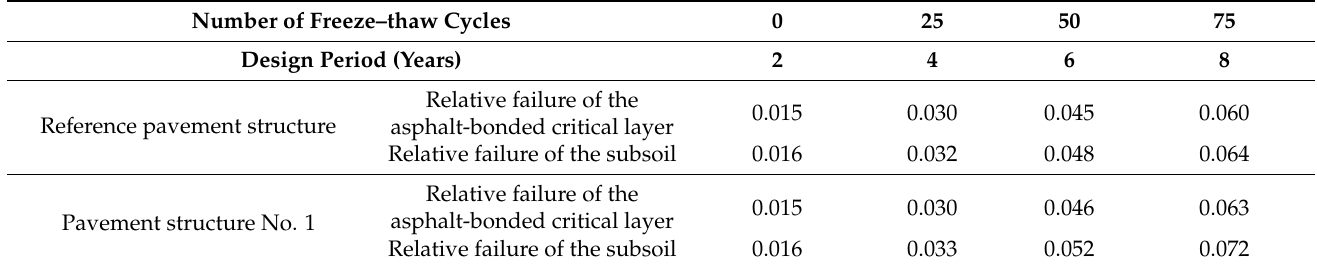
Table 6. Assessment of pavement structure No. 1 and relative failure of D cd (change in the modulus of stiffness of wearing course due to the number of freeze–thaw cycles).